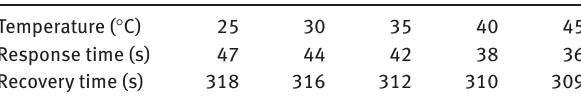
Table 2: Variation of sensor response and recovery time with temperature.